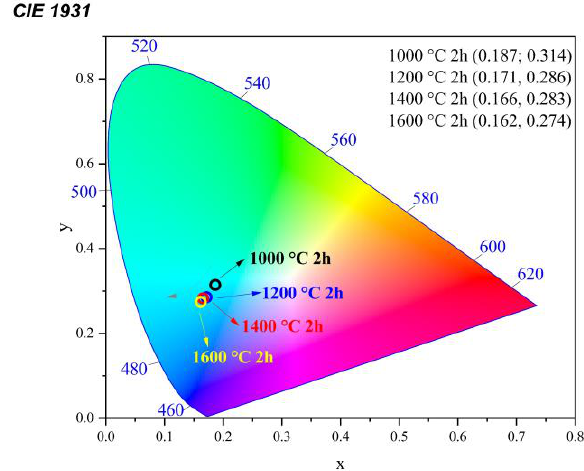
Fig. 2. Chromaticity Diagram for HfO 2 calcined at different temperatures.